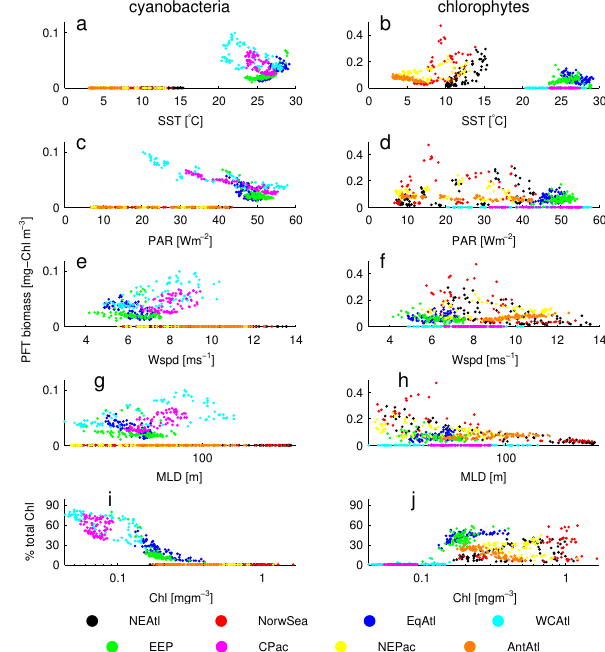
Fig. 3. Scatter plots showing the emerging relationship between PhytoANN diatom (left column) and coccolithophore (right col- umn) biomass [mgChlm − 3 ] (a–h) or % of total Chl (i, j) vs. in- dividual ecological indicators color coded according to domain of origin. On the x axis from top to bottom: SST, PAR, Wspd, MLD and Chl. All data points come from exploratory analysis only, and thus they are box-average and monthly average estimates from Oc- tober 1997 to December 2004.